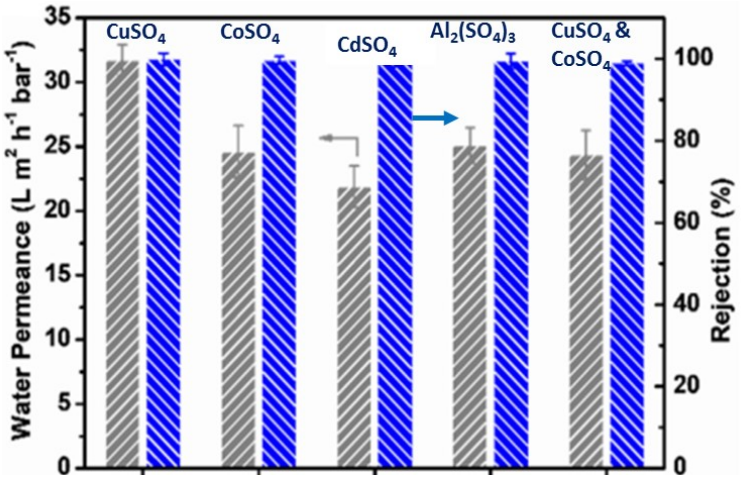
Figure 5. Rejections of different heavy metal ions (All ion solution concentration: 10 mM; Pressure = 1 bar; T = 25 °C). Adapted with permission from ref. [105]. Copyright 2021 Elsevier.